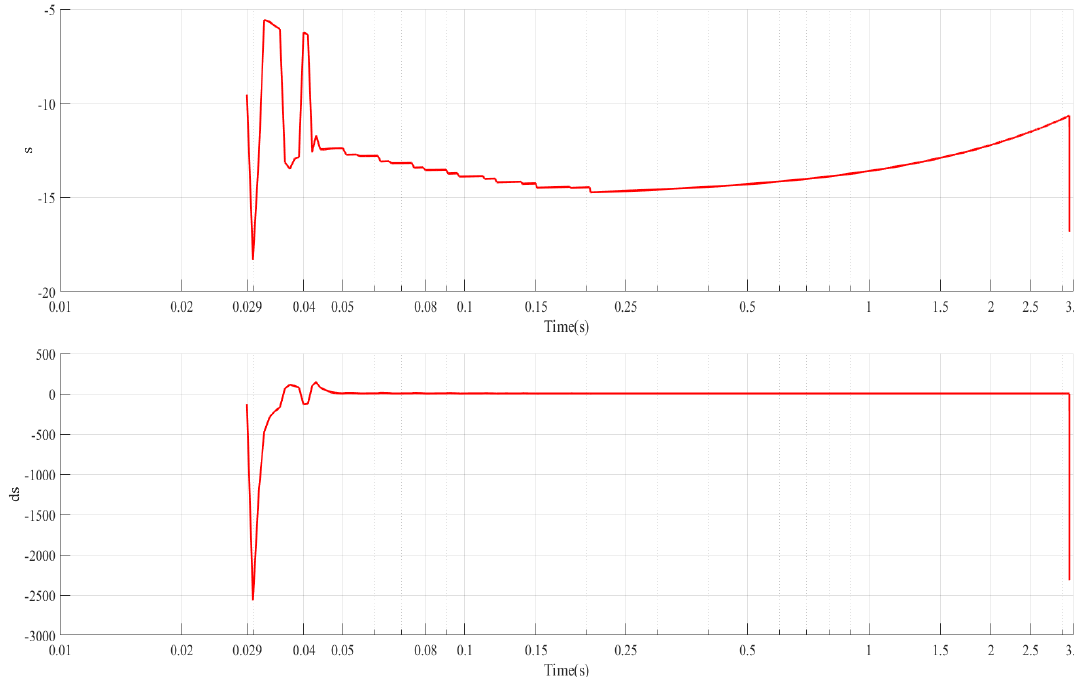
Figure 15. The adaptive sliding